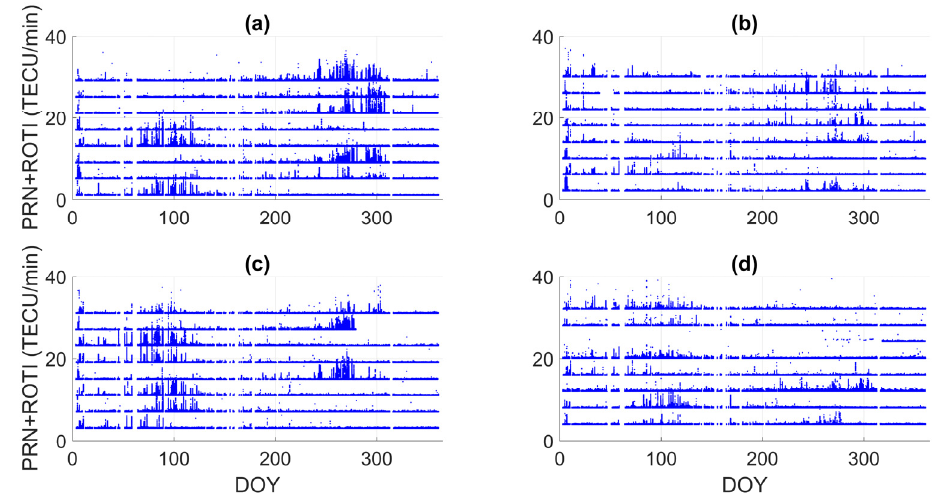
Figure 5. The time series of ROTI by day of year (DOY) for all of the observed GPS satellites at the QION site during 2012. The PRN numbers of each subfigure are as follows: ( a ) 1, 5, 9, 13, 17, 21, 25, 29; ( b ) 2, 6, 10, 14, 18, 22, 26, 30; ( c ) 3, 7, 11, 15, 19, 23, 27, 31; ( d ) 4, 8, 12, 16, 20, 28, 32.